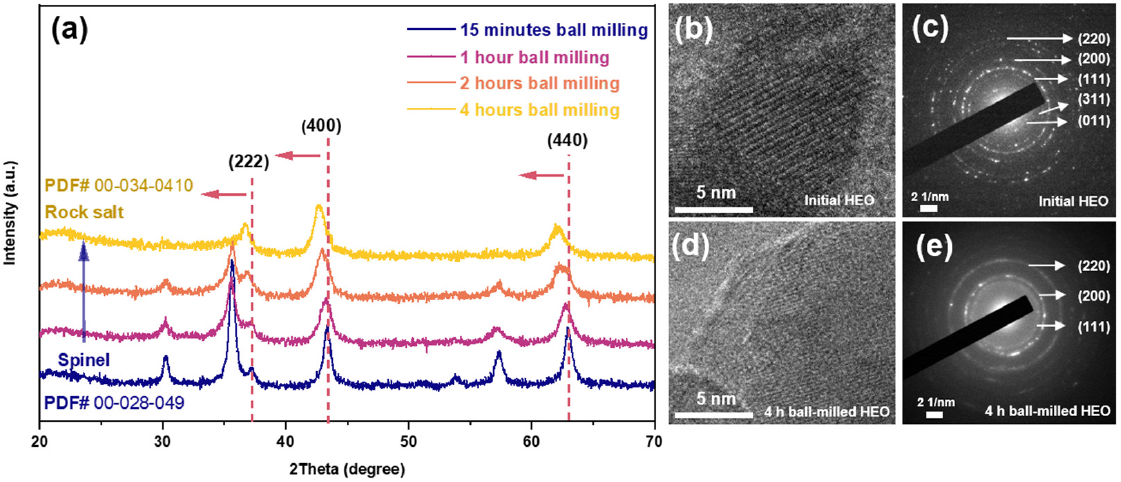
Figure 6. ( a ) XRD patterns of 6 - SHEO with different ball milling treatments. HRTEM and corre- sponded SEAD of ( b , c ) initial 6-SHEO, and ( d,e ) 4 h ball-milling treated 6-SHEO. sponded SEAD of ( b , c ) initial 6-SHEO, and ( d , e ) 4 h ball-milling treated